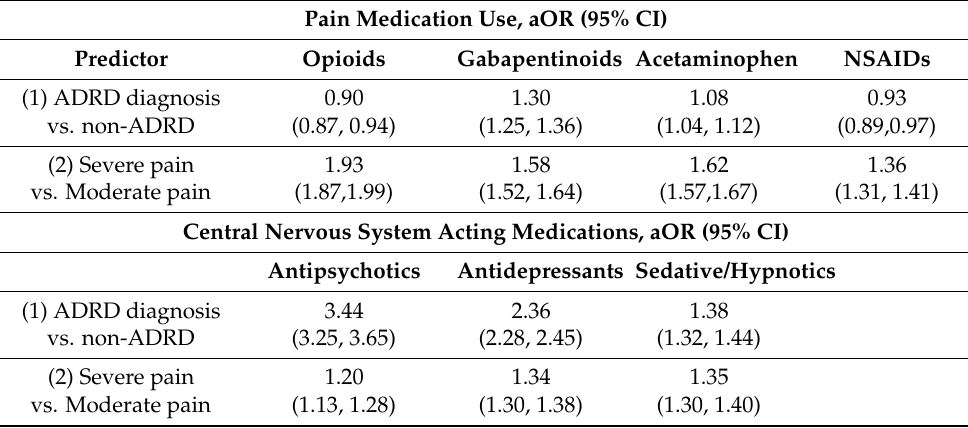
Table 3. Association between ADRD and pain intensity for pain medication and central nervous system acting medications use during 90-days prior to hospitalization in FY 2013 among 96,224 Veterans 65 and older with moderate to severe